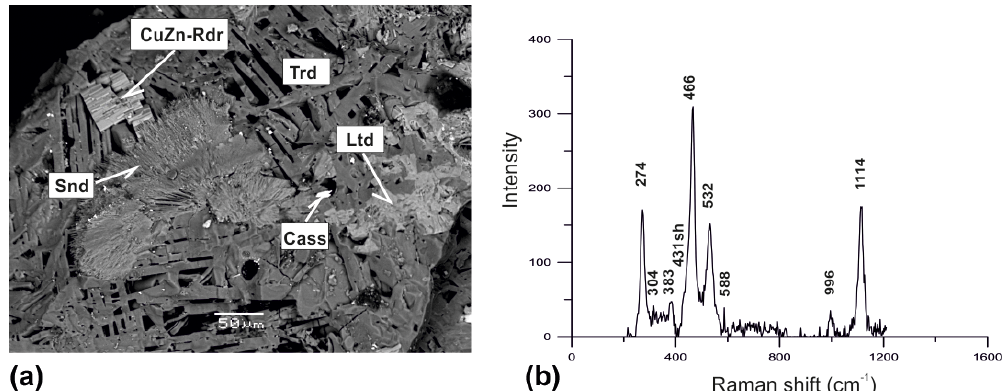
Figure 6. Parallel intergrowth of prismatic crystals of a Cu,Zn-rich analogue of roedderite (CuZn-Rdr) on aggregate of platy crystals of tridymite (Trd) in association with sanidine (Snd), litidionite (Ltd) and cassiterite (Cass). BSE image (a) ; Raman spectrum of randomly oriented sample of Cu,Zn-rich analogue of roedderite from the Arsenatnaya fumarole (b) .